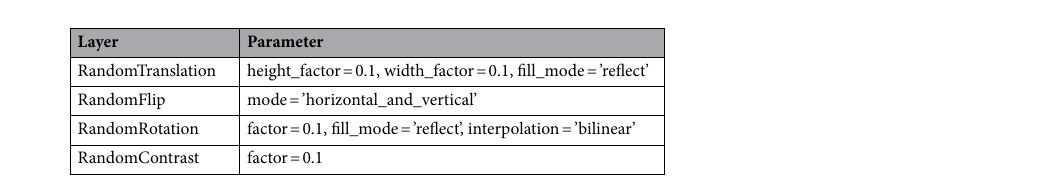
Table 3. Image data augmentation layers and parameters.